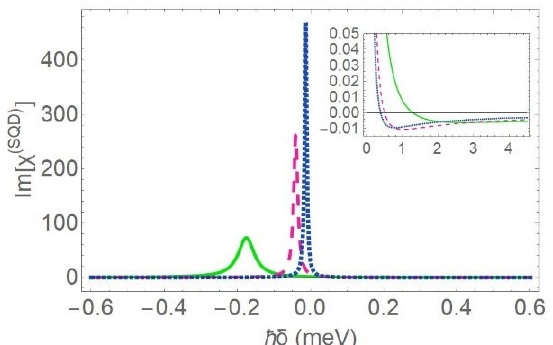
Figure 6. The linear absorption spectra for the SQD, for different values of the center-to-center distance (green solid curve: R = 11.5 nm, pink dashed curve: 13.5 nm, blue dotted curve: 15.5 nm and turquoise dashed-dotted curve: 100 nm). The dielectric constant of the core ε c is set equal to 7.5, the inner radius of the MNS r 1 is set equal to 7 nm and the rest physical parameters take the same values as in Figure